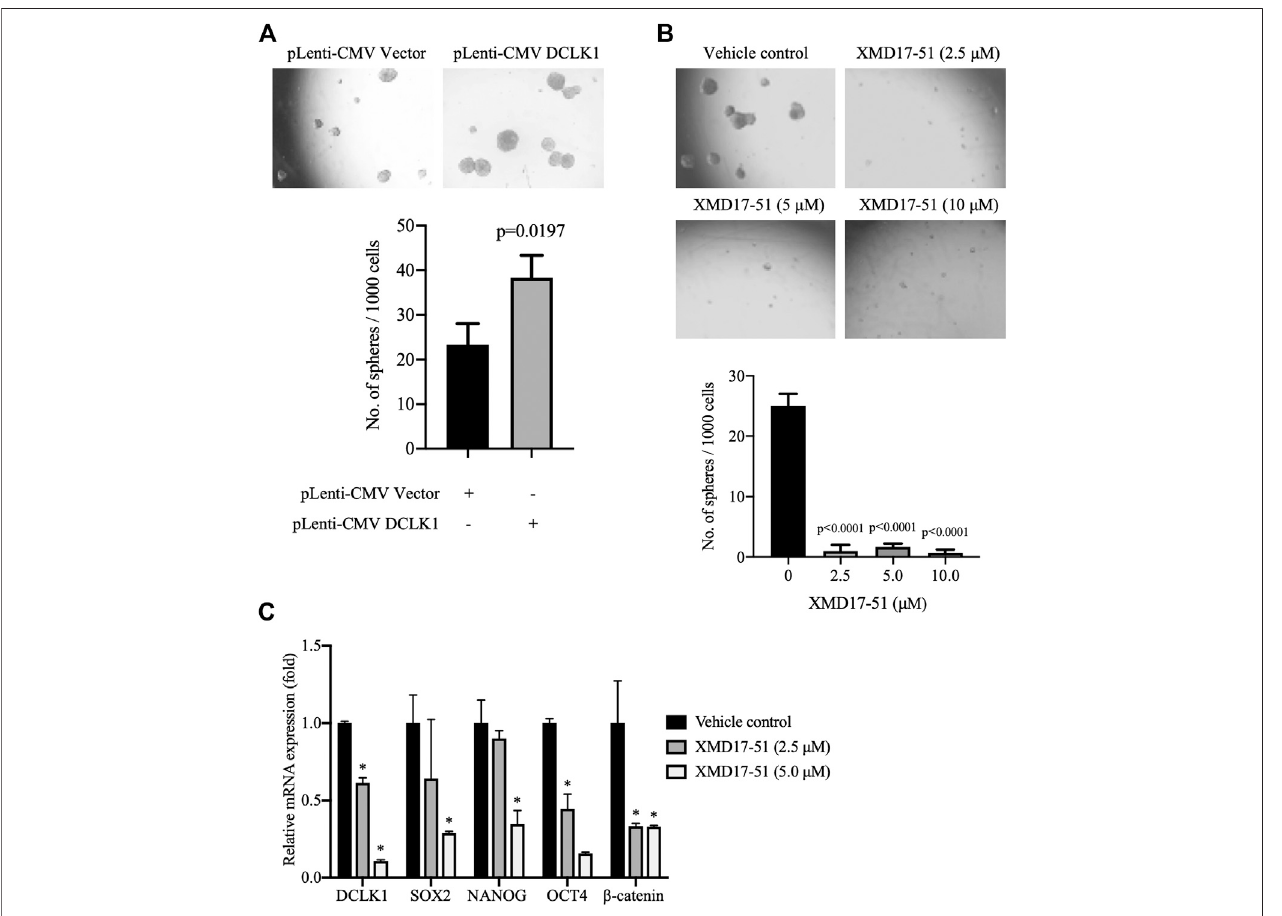
FIGURE 4 | XMD-17-51 inhibits cancer cell stemness in A549 cells. (A) DCLK1 overexpression promoted sphere formation from A549 cells. Cells (1,000 cells/well) were suspended in stem cell medium. Spheres were counted 7 days after treatment and sphere formation ef fi ciency is presented as the mean ± SD. (B) XMD-17-51 inhibited sphere formationfromA549cells.A549cells(1,000cells/well)weresuspendedinstemcellmediumandtreatedwithXMD-17-51atdifferentconcentrations.Sphereswerecounted10days after treatment. Sphere formation ef fi ciency is presented as the mean ± SD. (C) XMD-17-51 decreased cancer stem cell markers of A549 cells, as shown by RT-qPCR (normalization to GAPDH levels). Data are shown as a fold change relative to the levels in vehicle control cells and are presented as mean ± SD. DCLK1, doublecortin-like kinase 1.